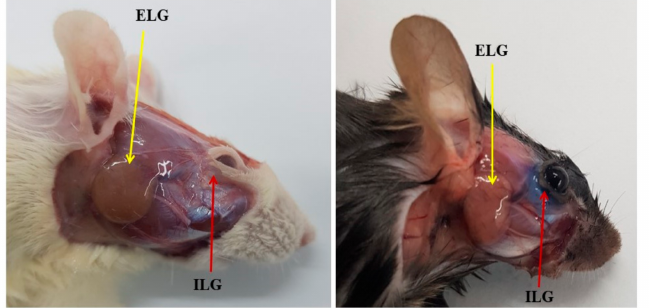
Figure 1. Location of the external (ELG) and internal lacrimal glands (ILG) in Sprague–Dawley rat ( left ) and C57BL/6 mouse ( right